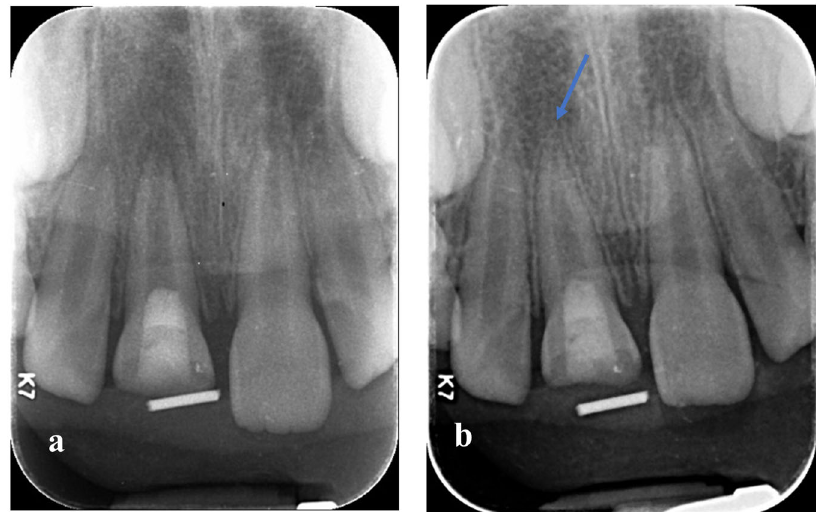
Fig. 8 Digital periapical radiographic images of immature upper right central incisor representative for Group (W) showing continuing root lengthening. a Baseline immediate post-operative radiograph showing the immature root of upper right central incisor. b 12 months follow-up radiograph showing the increase in root length in upper right central incisor.